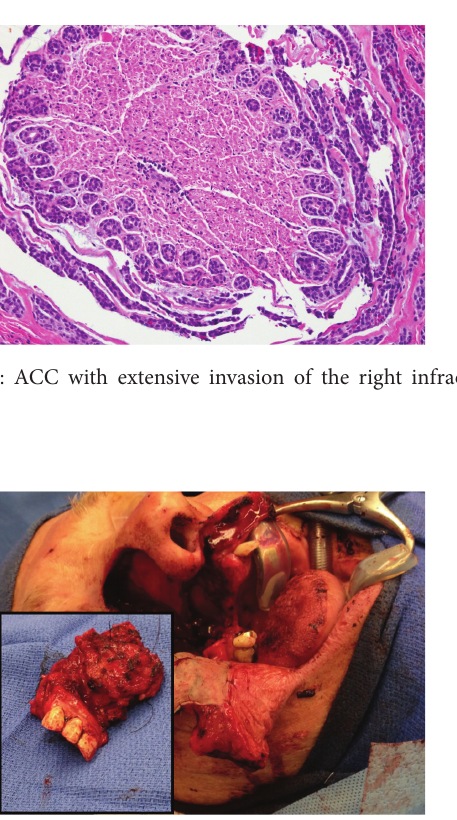
Figure 4: Split thickness graft reconstruction with inset showing resected tumor mass measuring 3.5